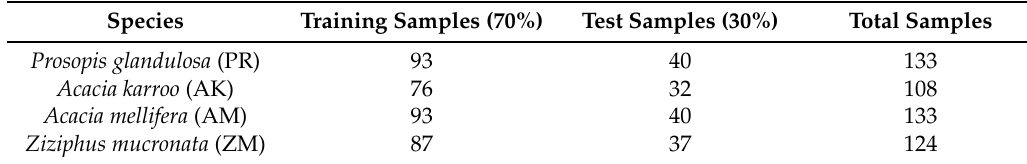
Table 1. Sample plots of Prosopis glandulosa and its co-existent species.